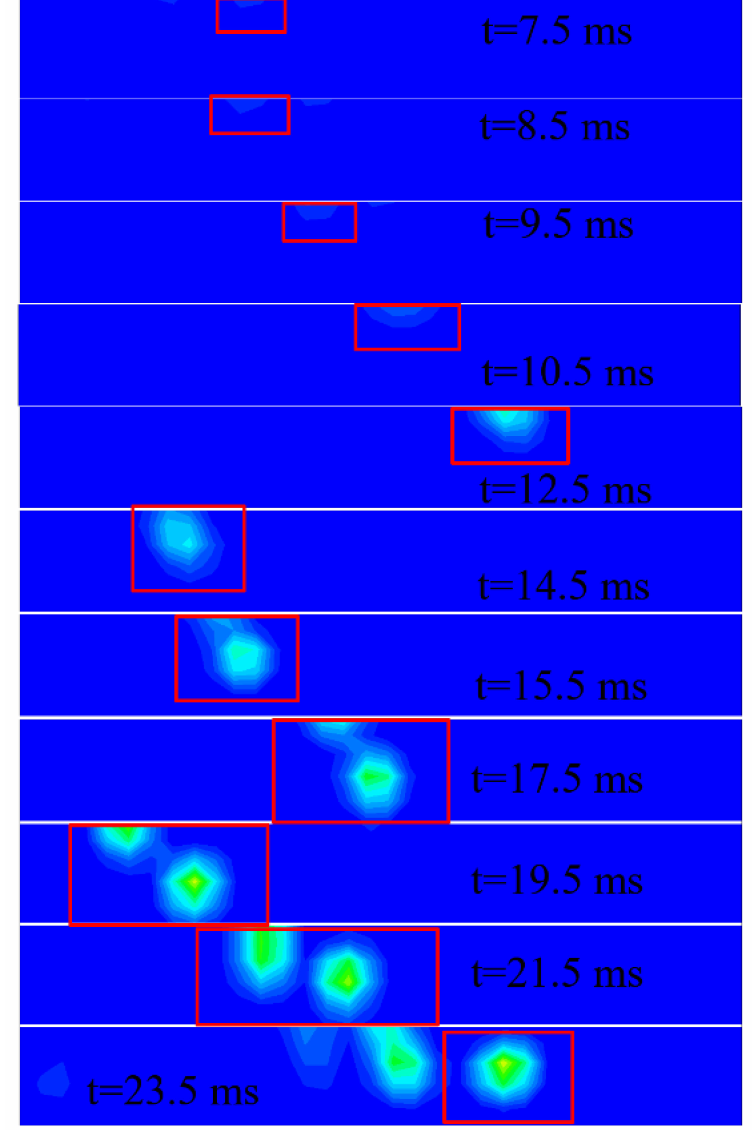
Figure 10. The developing process of a continuous-boiling bubble with time. Except for the five bubbles described above, the characteristic of all bubble departure was investigated. Figure 11 shows the bubble departure diameter of 12 bubbles at a heat flux of 0.3 MW/m 2 , inlet velocity of 0.4 m/s, and inlet subcooling of 3 K. As can be seen from Figure 11, the bubble departure diameter is widely in the range of 0.25 to 0.35 mm. However, there are bubbles with diameters above 0.4 mm and below 0.25 mm. This is because different bubble nucleation points have different positions, and the difference between the local heat transfer and the flow field velocity in different positions makes the characteristics of bubble departure quite different. The heat flux, inlet velocity, and inlet subcooling are important factors affecting bubble departure, which are discussed in the next